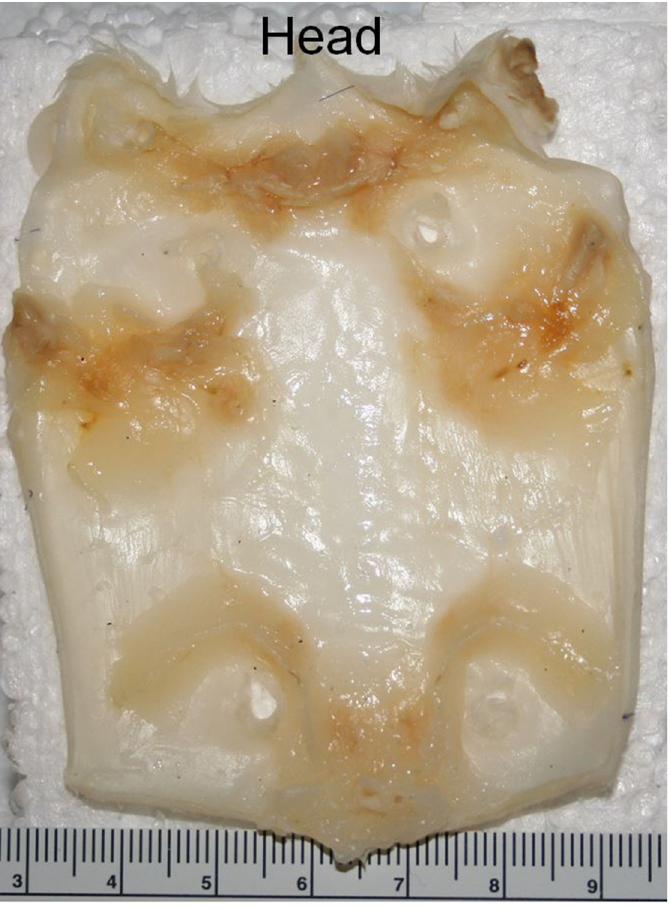
Fig 1. Photograph of excised skin from a mouse after treatment with formaldehyde before preparation for ex vivo imaging. The scale of the ruler is in millimeters.